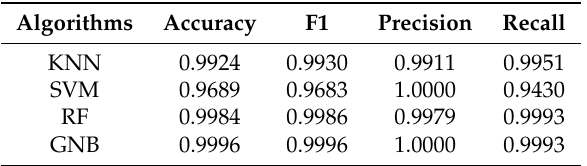
Table 3. Results of APNs identification using different algorithms.